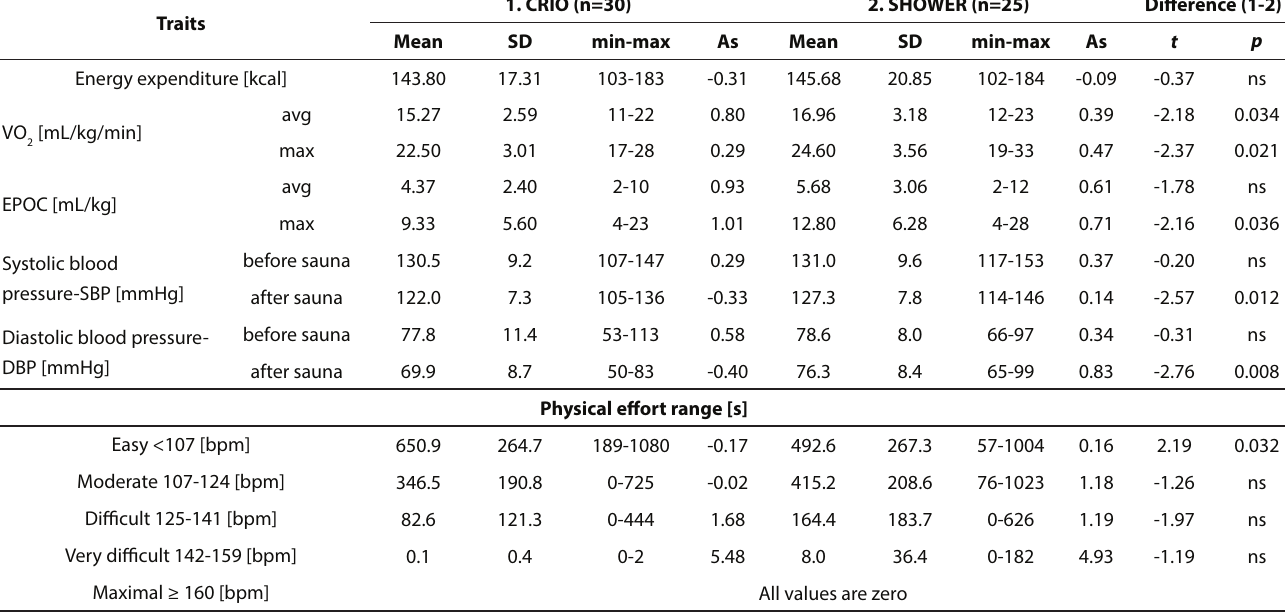
TABLE 3. Descriptive statistics of the studied physiological parameters in (CRIO) and (SHOWER) groups